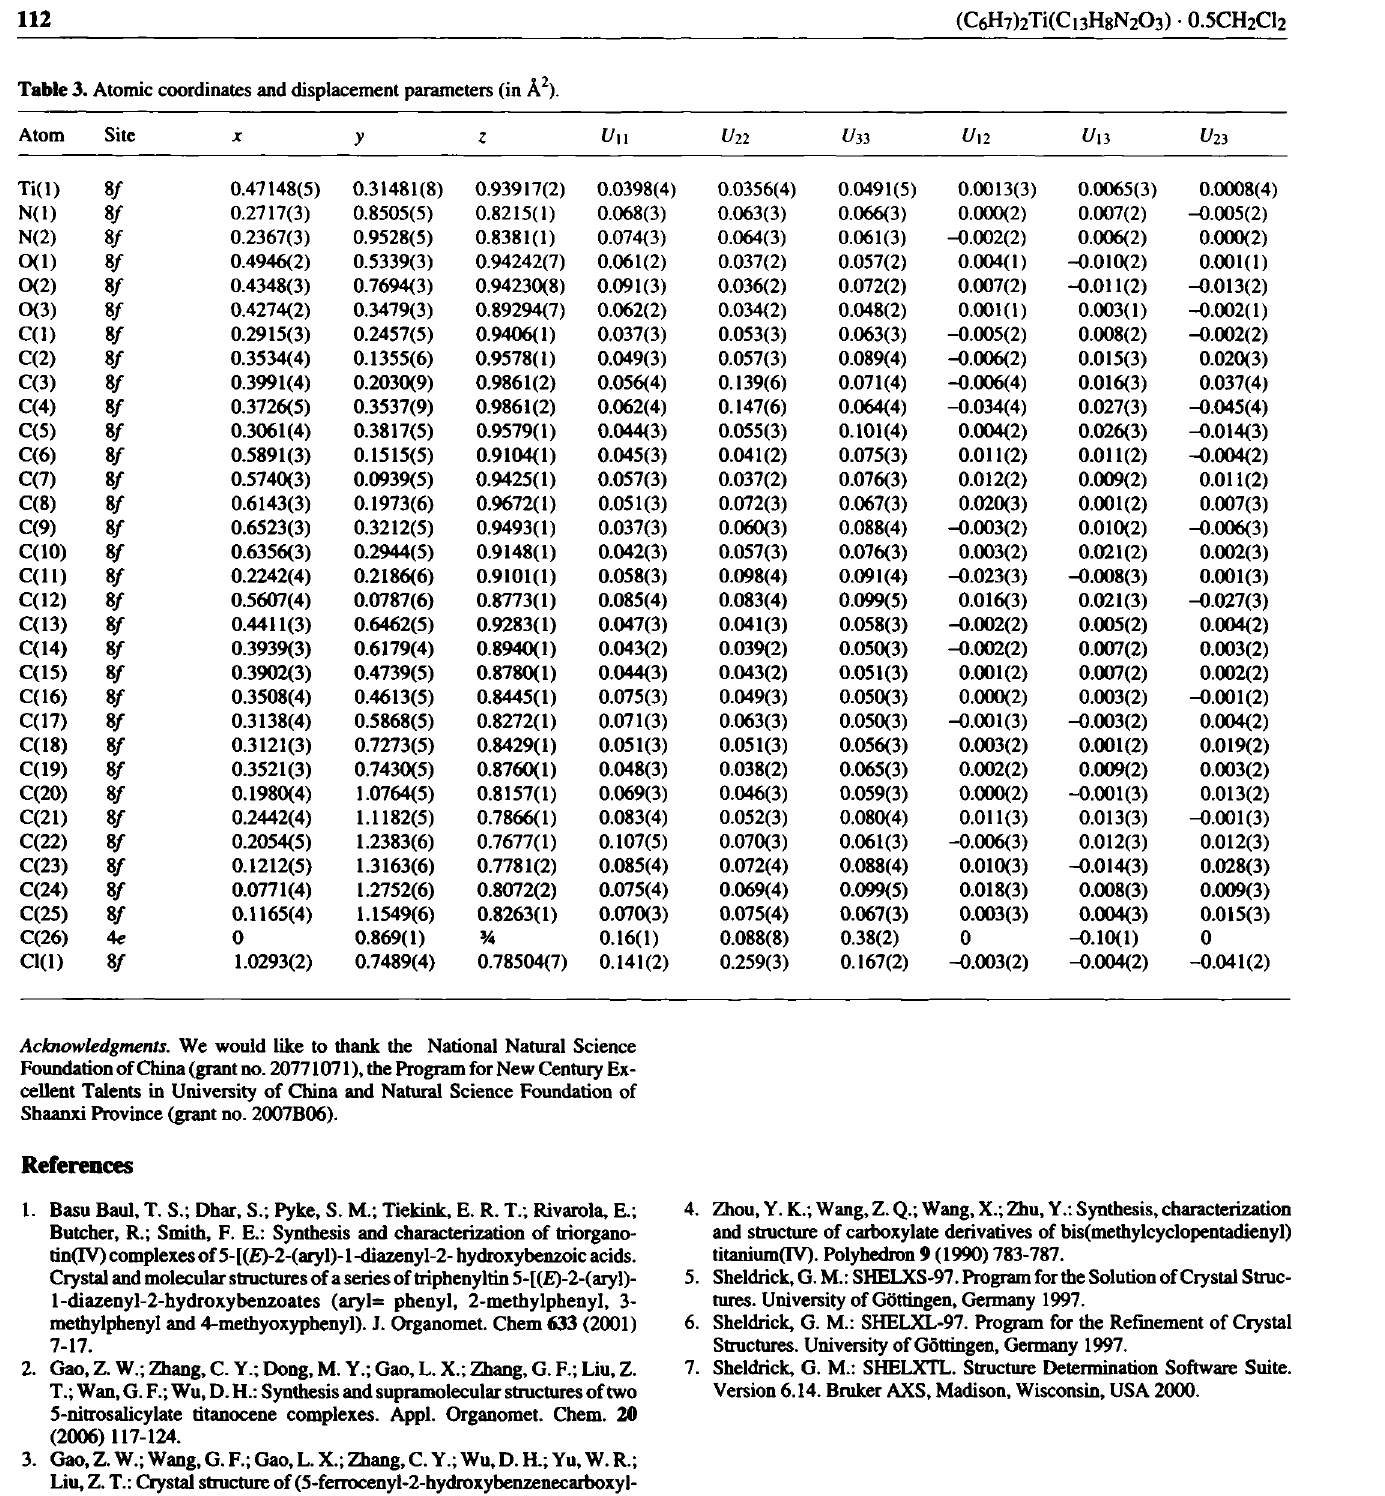
Table 3. Atomic coordinates and displacement parameters (in Â 2